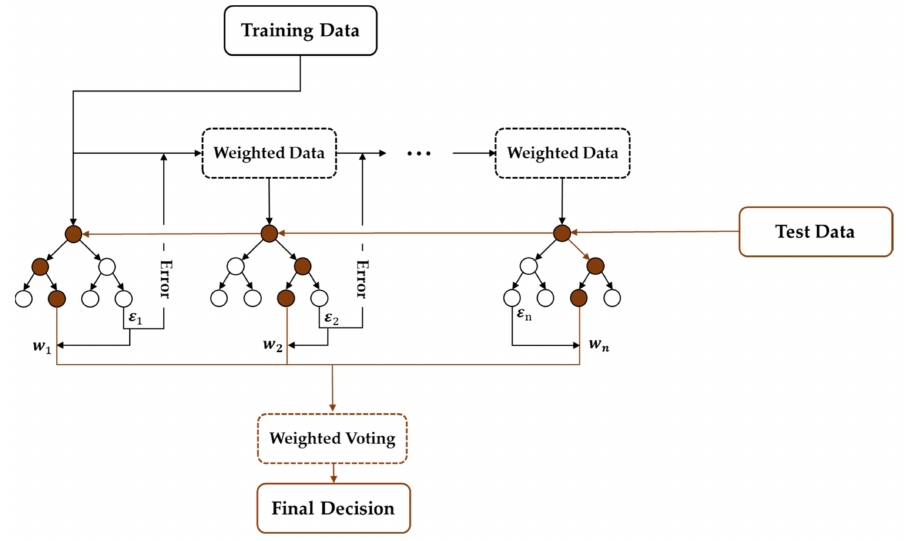
Figure 5. The structure of adaptive boosting (AdaBoost). AdaBoost generates multiple weak learners. Unlike RF, previous decision trees (DTs) affect the next DT by using the classification errors to weigh the misclassified data. The final decision is performed with weighted voting from multiple trees based on the error of each